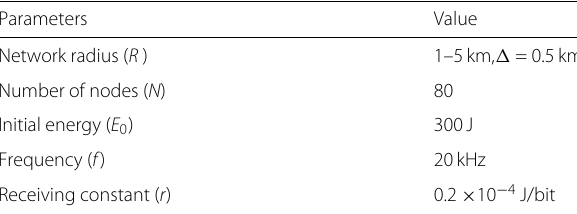
of the transmission distance, d max and d min . Transmitting